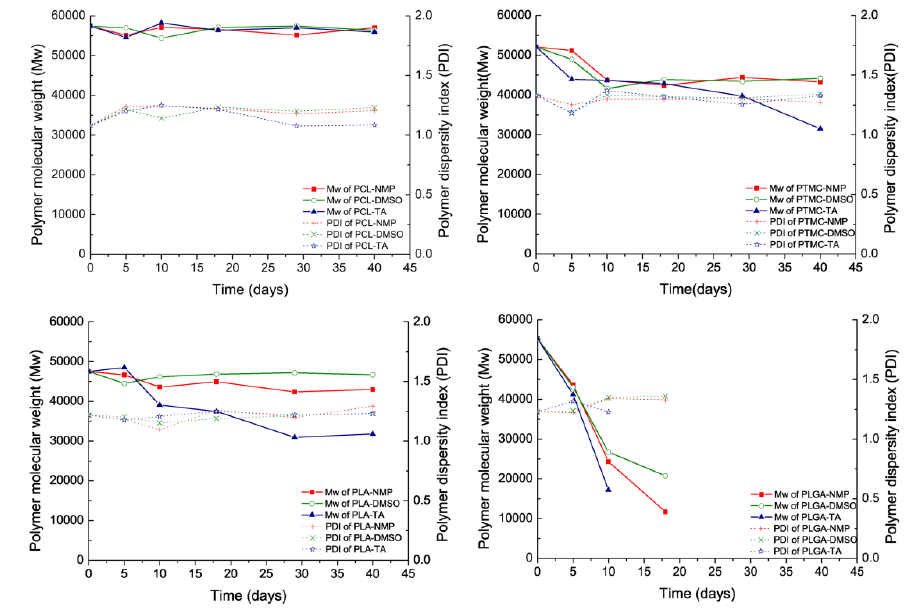
Figure 3. The changes in the molecular weight (Mw) of the ISFIs as well in the polydispersity index (PDI) (Mw/Mn). (mean ± S.D., n = 3).